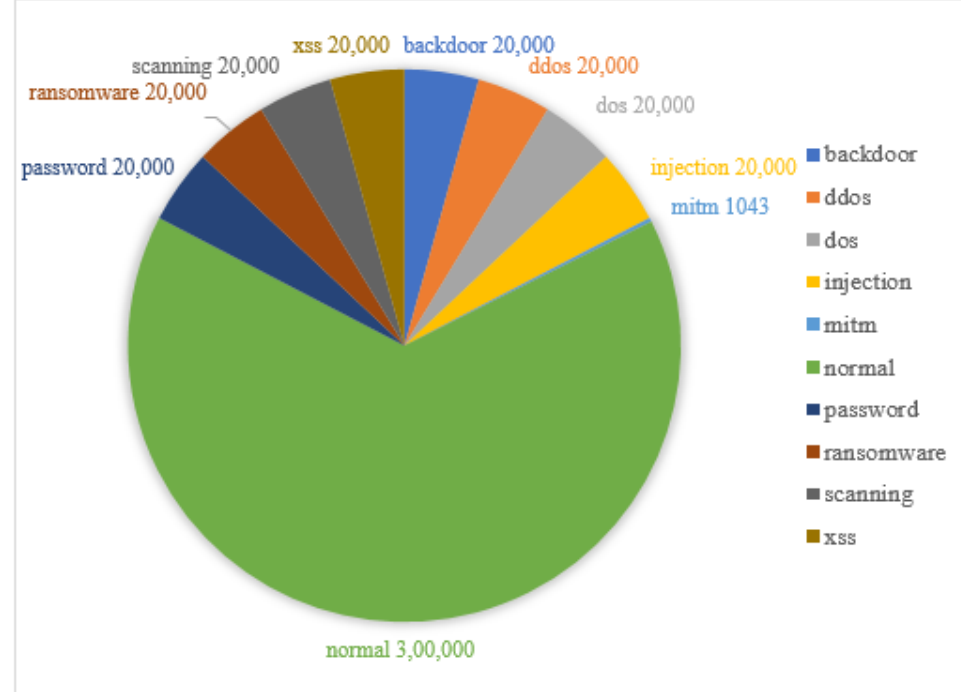
Figure 3. TON IoT train-test network dataset statistics.